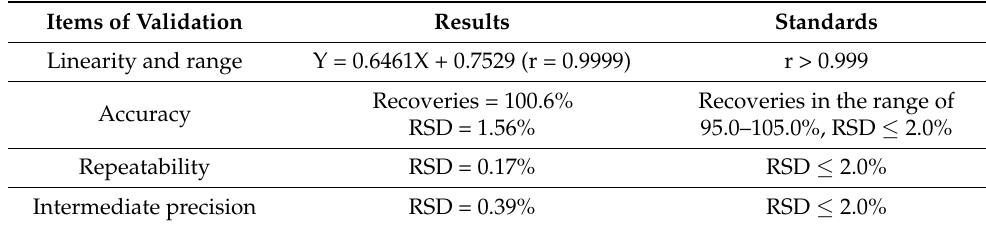
Table 6. Results of analytical method validation.